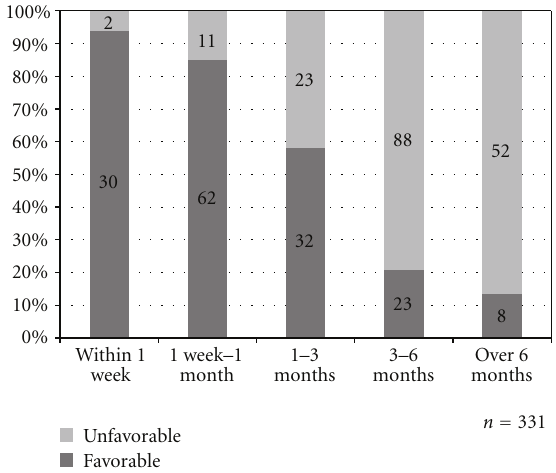
Figure 3: Patient response towards waiting time for colonoscopy appointment across the di ff erent duration of waiting time for colonoscopy appointment ( P < 0 . 001 across each of the categories of waiting time).